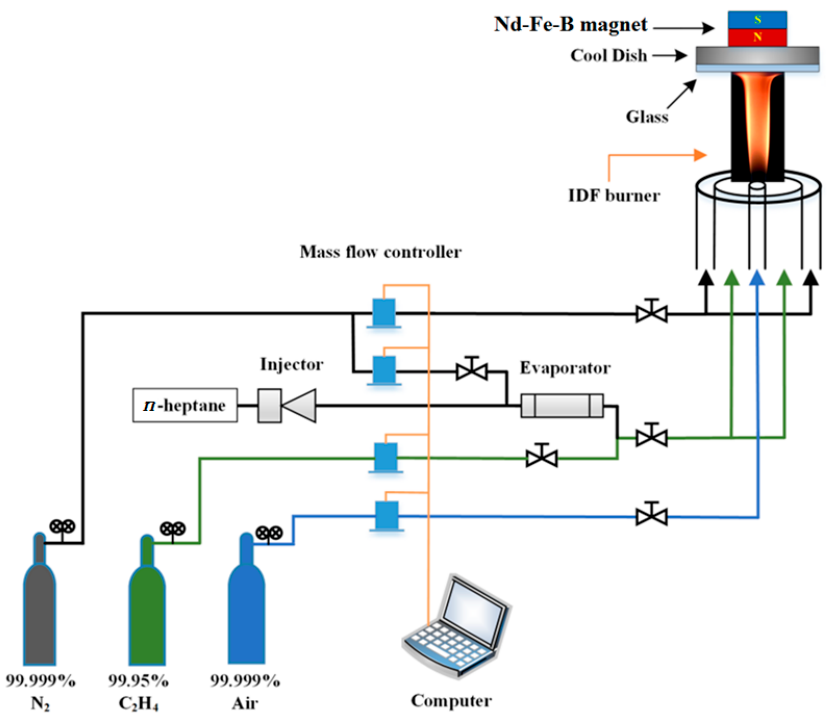
Figure 1. Schematic of the experimental set up.